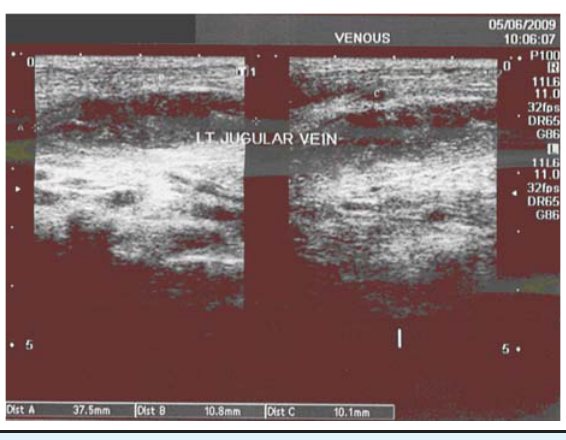
Figure 2. Doppler ultrasound showing dilated left IJV containing a